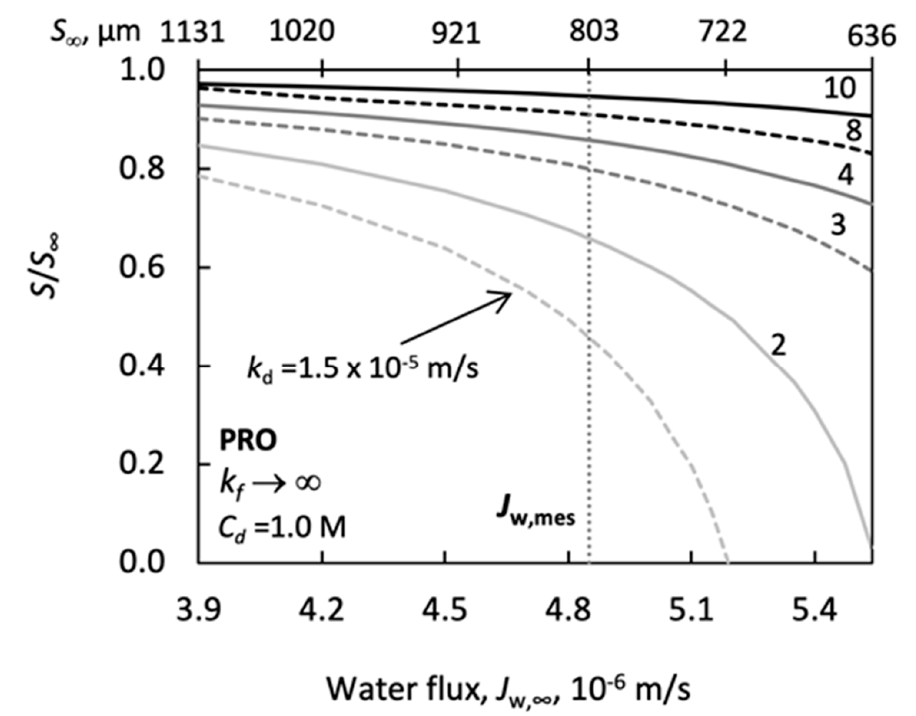
Figure 10. Change of the S/S ∞ values as a function of the water flux in a PRO system, taking into account their predicted error of the measured data ( ± 20%), given by Manickam and McCutcheon [40]. Parameter is the external mass transfer coefficient in the boundary layer facing the active membrane layer, at C d = 1.0 M, and k f → ∞ ( A = 1.71 × 10 − 7 m/s · bar; B = 1.94 × 10 − 7 m/s; C f = 0; S = 803 × 10 − 6 m; ∆ P = 0; D = 1.5 × 10 − 9 m 2 /s). On the upper horizontal axis, the calculated value of the corresponding structural parameter is given for k d → ∞ , k f → ∞ .